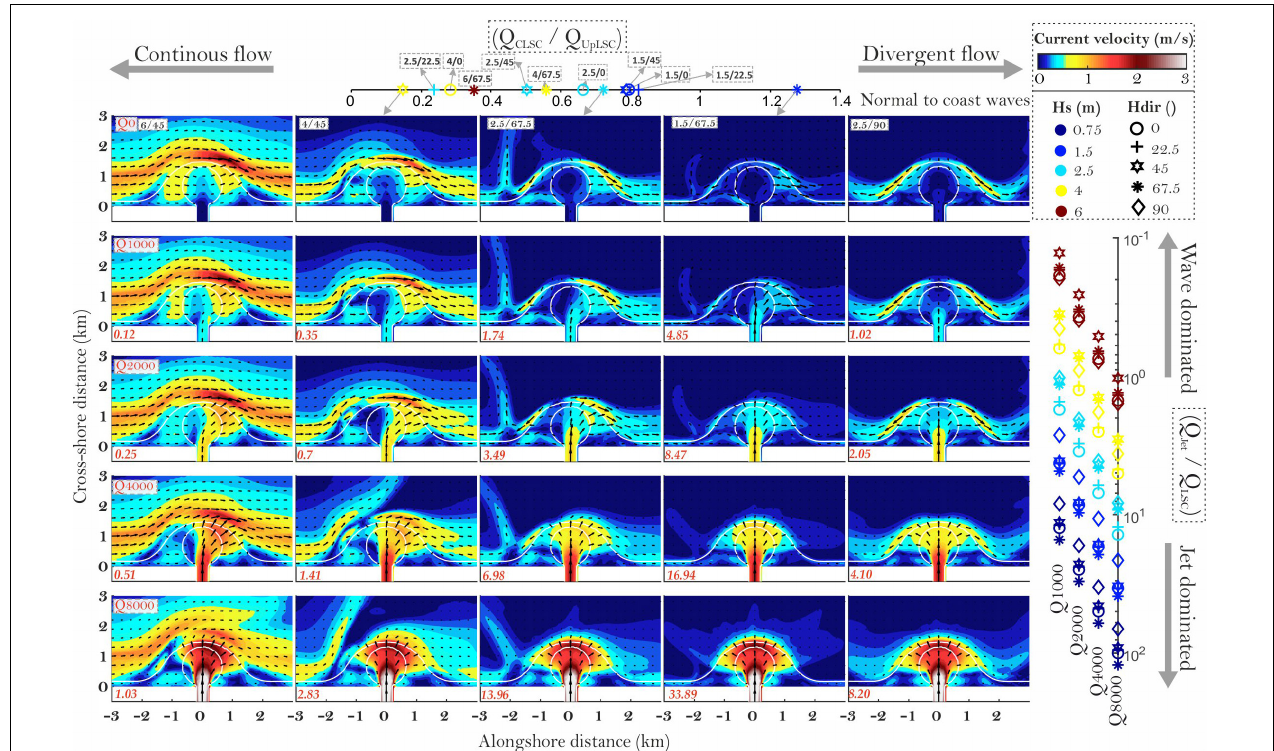
FIGURE 7 | Circulation patterns for the Big RMB case with a selection of wave heights, directions, and river discharges. Values in left bottom corner of each plot show the Q Jet / Q LSC